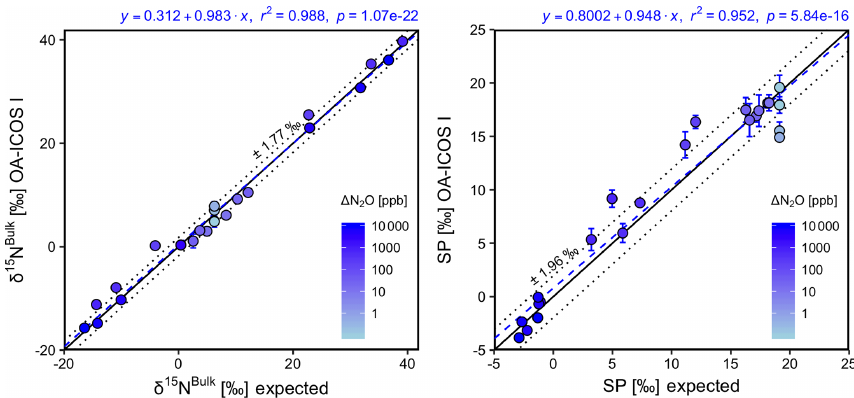
Figure 9. Correlation diagrams for δ 15 N bulk and SP measurements at various (cid:49) N 2 O mole fractions analyzed by OA-ICOS I plotted against expected values. The remaining plots for [ N 2 O ] , δ 15 N α , δ 15 N β and δ 18 O are provided in Sect. S4 (Fig. S4-10). The solid black line denotes the 1 : 1 line, while the dotted line indicates ± 1 σ of the residuals from the 1 : 1 line. The dashed blue line represents a linear fit to the data. Individual equations, coefficients of determination ( r 2 ) and p values are indicated above each plot. Each data point represents the mean and standard deviation (1 σ ) of triplicate measurements. The inset plots indicate the standard deviation (1 σ ) of the triplicate measurements achieved at different (cid:49) N 2 O mole fractions, and the 1 : 1 line is similarly a solid line.